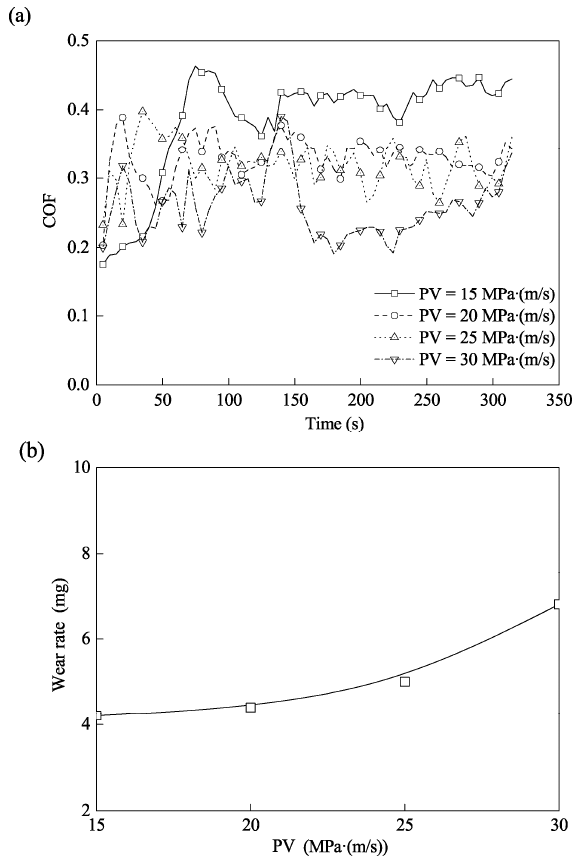
Fig. 10 (a) COFs and (b) wear rate with the S07steel disk under the water-lubricated conditions.